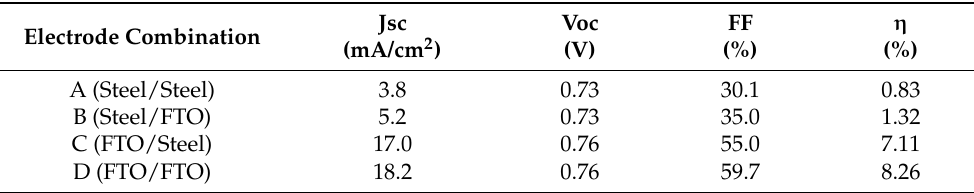
Figure 6. ( a ) J–V Characteristics curve of cells assembled with four different electrode combinations, ( b ) J–V characteristics curve of stainless-steel counter electrode cells assembled with two different metal photoanodes. Table 2. Performance of different electrode combination batteries.